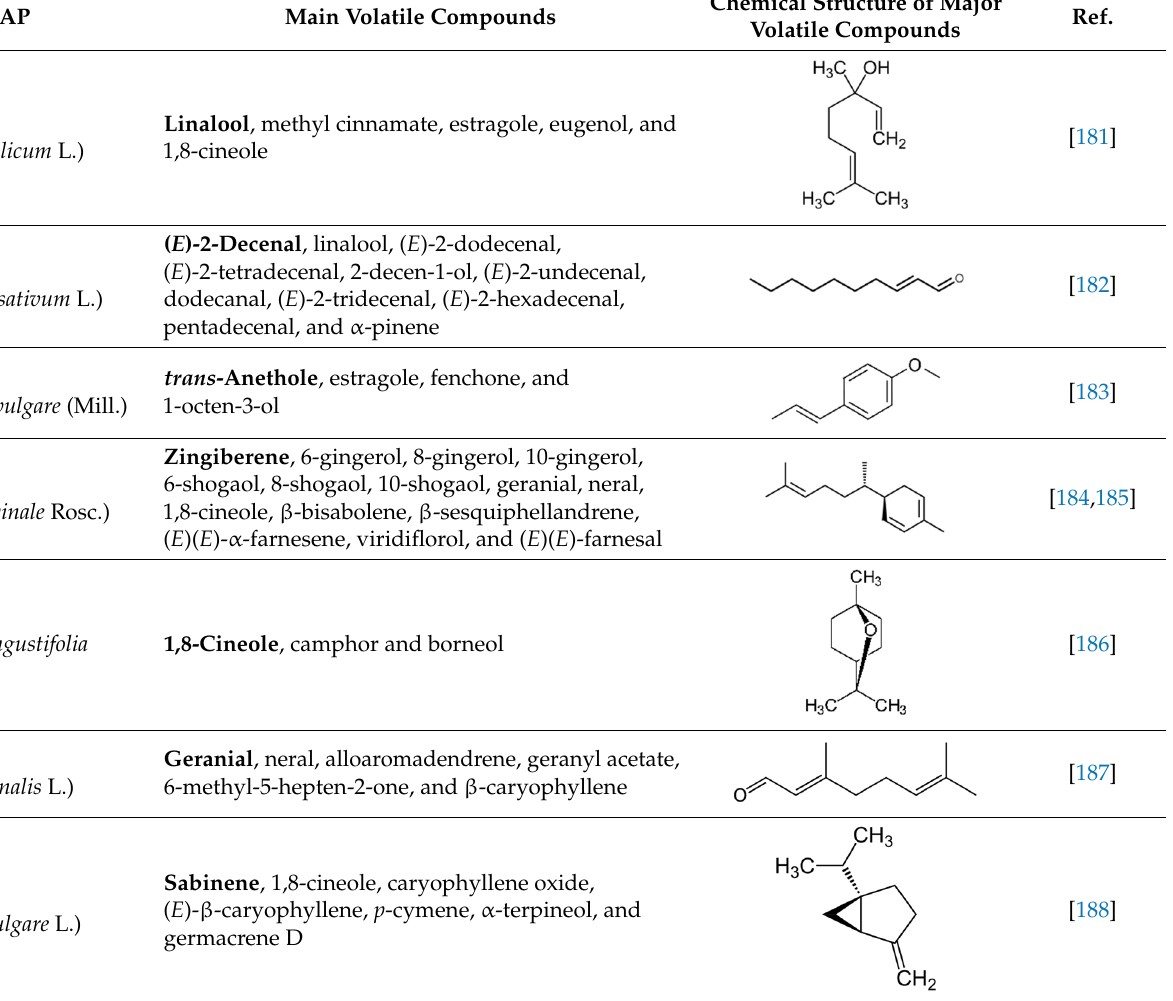
that the typical “spicy” and “fresh” aromas exhibited by ginger is due to the simultaneous presence of different compounds such as zingiberene, 6-gingerol, 8-gingerol, 10-gingerol, 6-shogaol, 8-shogaol, geranial, and neral. These compounds, even in lower amounts, are critical for the consumer to perceive the typical aroma of ginger, all of them are important to define the ginger “bouquet”. Table 6. Key volatile compounds present in some medicinal and aromatic plants (MAPs). In bold are the major volatile Table 6. Key volatile compounds present in some medicinal and aromatic plants (MAPs). In bold are the major volatile Table 6. Key volatile compounds present in some medicinal and aromatic plants (MAPs). In bold are the major volatile compounds of Table 6. Key volatile compounds present in some medicinal and aromatic plants (MAPs). In bold are the major volatile Table 6. Key volatile compounds present in some medicinal and aromatic plants (MAPs). In bold are the major volatile Table 6. Key volatile compounds present in some medicinal and aromatic plants (MAPs). In bold are the major volatile Table 6. Key volatile compounds present in some medicinal and aromatic plants (MAPs). In bold are the major volatile Table 6. Key volatile compounds present in some medicinal and aromatic plants (MAPs). In bold are the major volatile compounds of each MAP. The names of the compounds in bold are those represented in the figures. compounds of each MAP. The names of the compounds in bold are those represented in the figures. compounds of each MAP. The names of the compounds in bold are those represented in the figures. compounds of each MAP. The names of the compounds in bold are those represented in the figures. each MAP. The names of the compounds in bold are those represented in the figures. compounds of each MAP. The names of the compounds in bold are those represented in the figures. compounds of each MAP. The names of the compounds in bold are those represented in the figures. compounds of each MAP. The names of the compounds in bold are those represented in the figures. MAP Main Volatile Compounds MAP Main Volatile Compounds MAP Main Volatile Compounds MAP Main Volatile Compounds MAP Main Volatile Compounds MAP Main Volatile Compounds MAP Main Volatile Compounds MAP Main Volatile Compounds